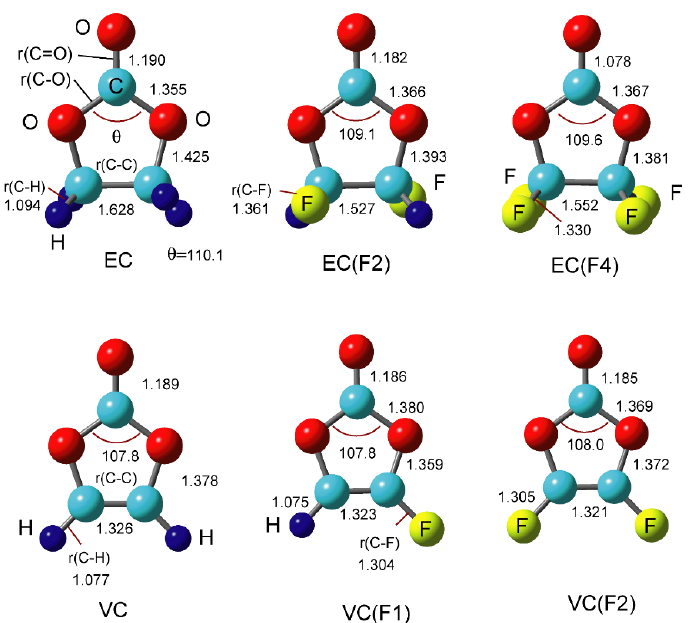
Figure 2. Optimized structures of EC, fluorinated ethylene carbonate (EC(F)), vinylene carbonate (VC) and fluorinated vinylene carbonate (VC(F)), calculated at the B3LYP/6-31G(d) level. The notation of